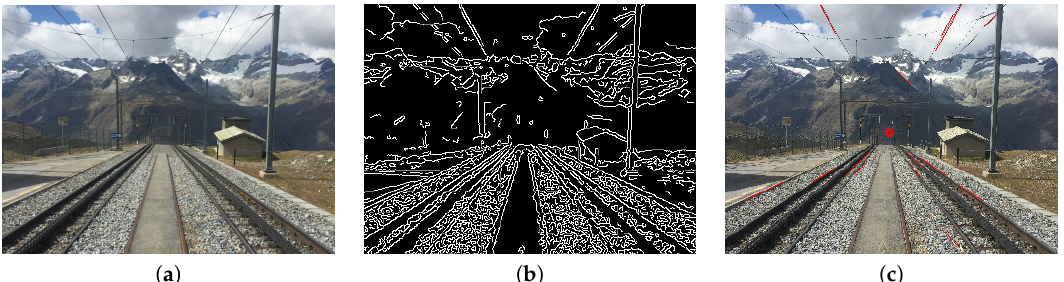
Figure 13. ( a ) Original image. ( b ) Edge detection result. ( c ) Vanishing point calculated result (enlarge to see the red detected lines).